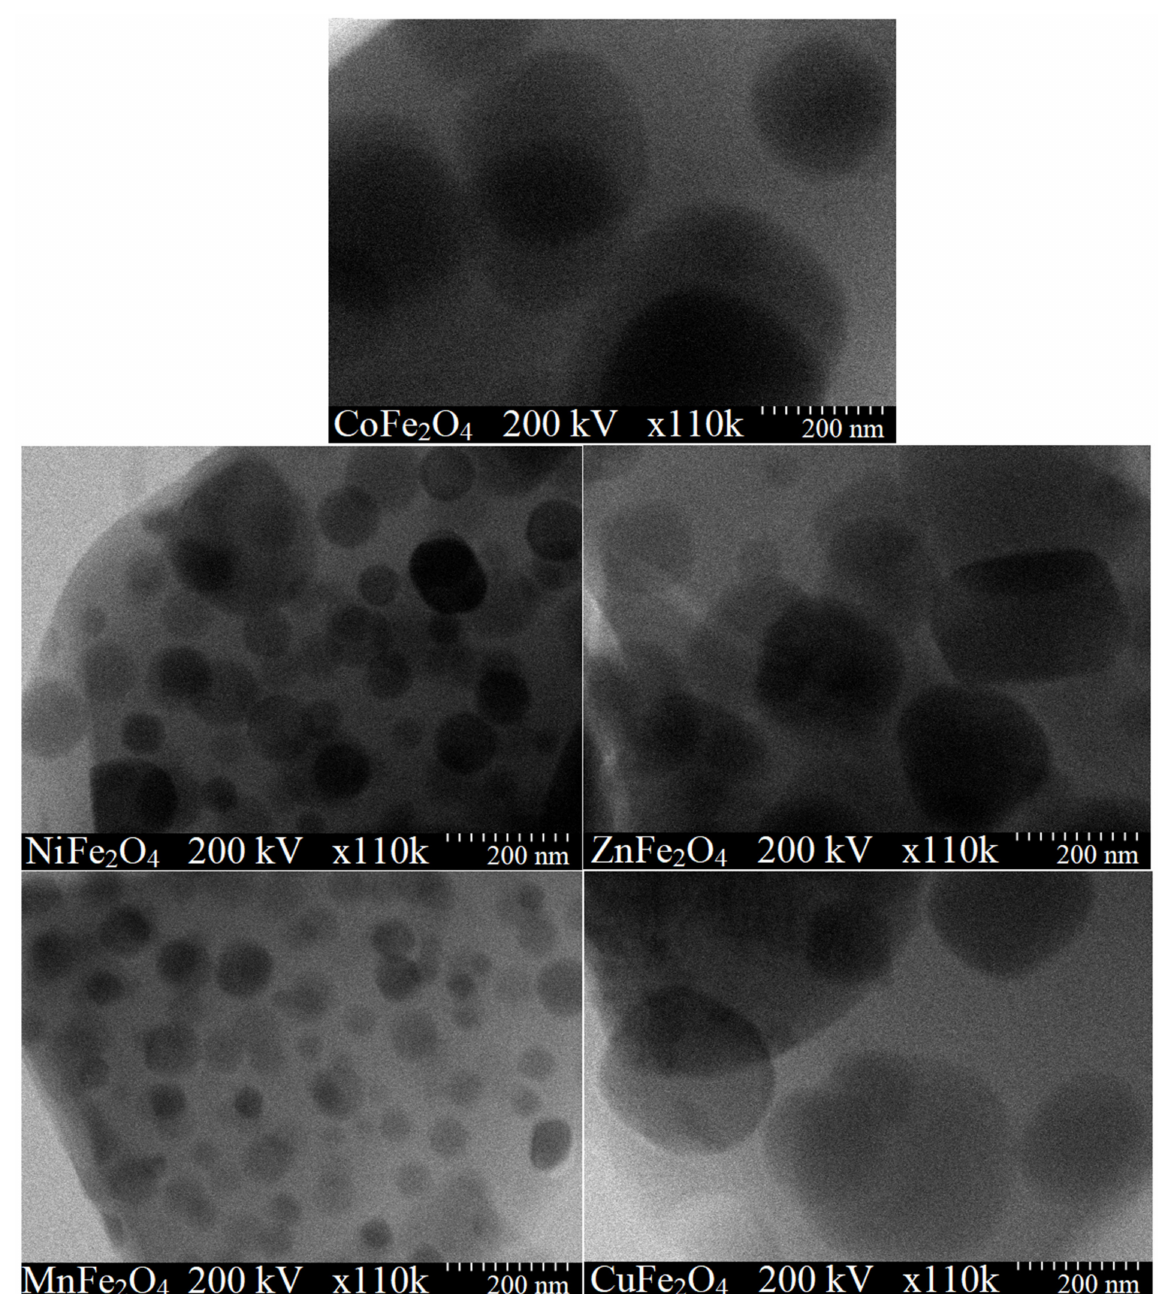
Figure 3. TEM images for MFe 2 O 4 (M = Co, Zn, Ni, Cu, Mn) heat treated at 1000 ◦